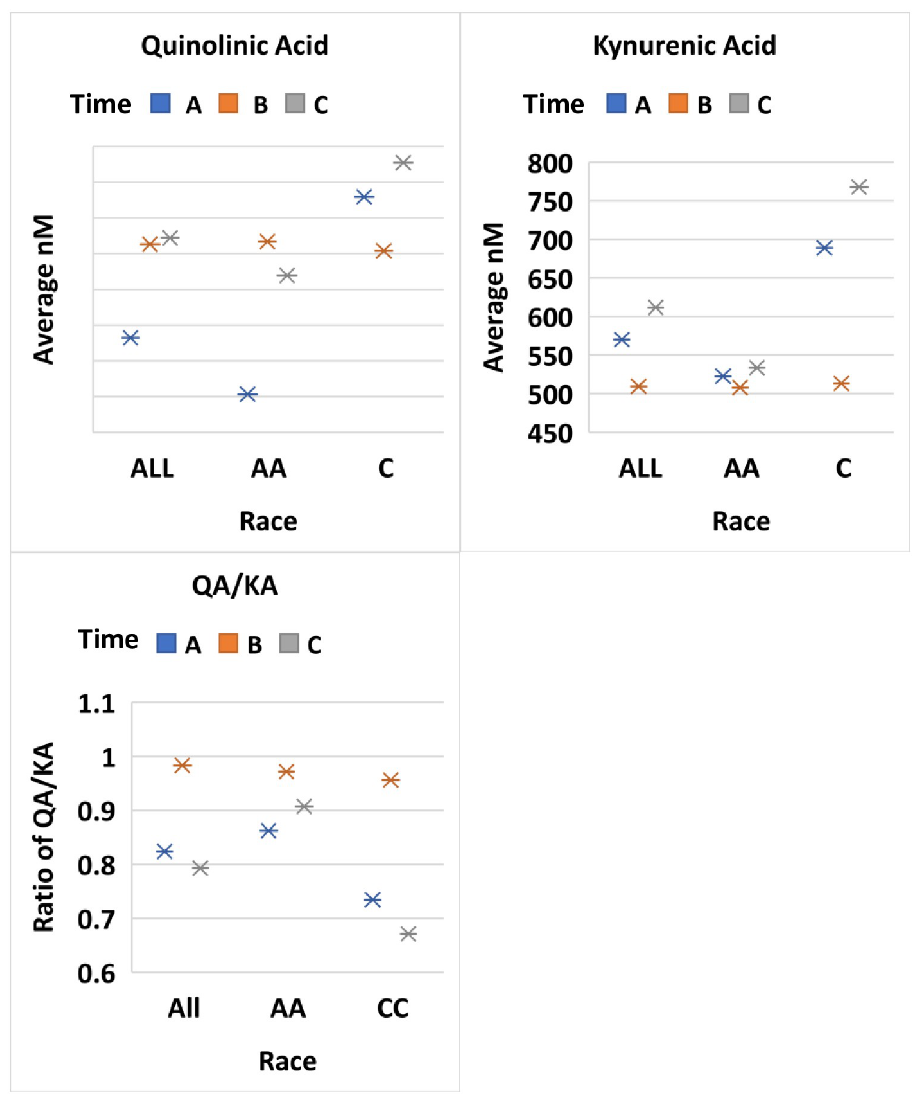
Fig 5. Comparison of treatment over 3 time points Time A at 6-12hours, Time B at 2 weeks and Time C at 3 months between all patients, African Americans and Caucasians for metabolites Quinolinic Acid (QA), Kynurenic Acid (KA) and